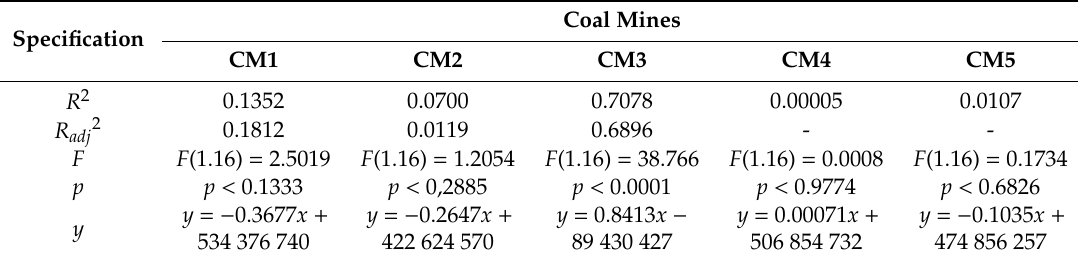
Table 7. Linear regression functions for examined coal mines (CM) (total costs dependency from production